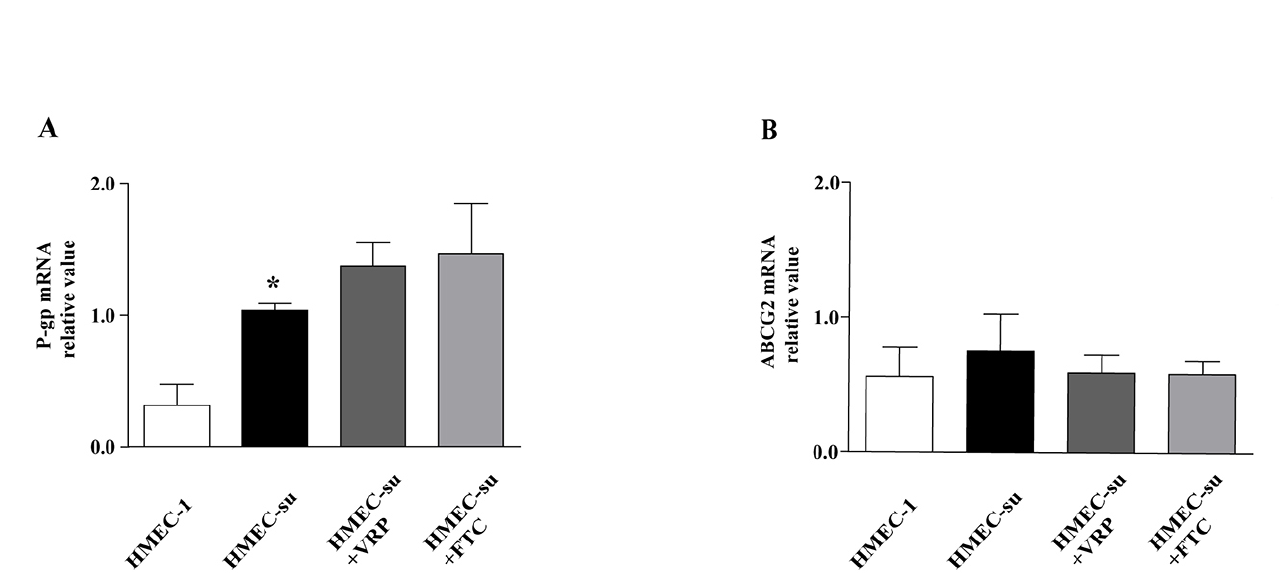
FIGURE S1 - The effect of P-gp and ABCG2 inhibitors on P-gp and ABCG2 gene expression. (A) P-gp and (B) ABCG2 mRNA level in HMEC-1 and HMEC-su cells using qRT-PCR, verapamil (VRP) at 100 µM and ABCG2 inhibitors fumitremorgin c (FTC) at 5 µM were used on both cells for 48h, respectively. **P < 0.01 and *P < 0.05 vs. HMEC-1